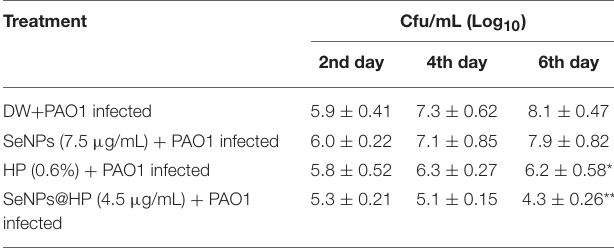
TABLE 2 | Bacterial load of wound area post P. aeruginosa PAO1 infection. TABLE 3 | Effect of SeNPs@HP on the wound healing in wound dripped with P. aeruginosa